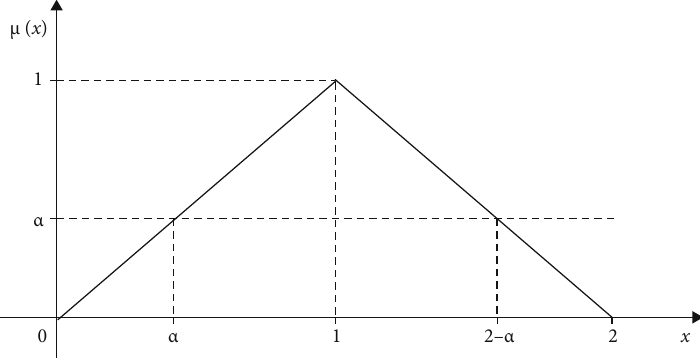
Figure 6: Graphical illustration for the α -level set of ~ A in Example